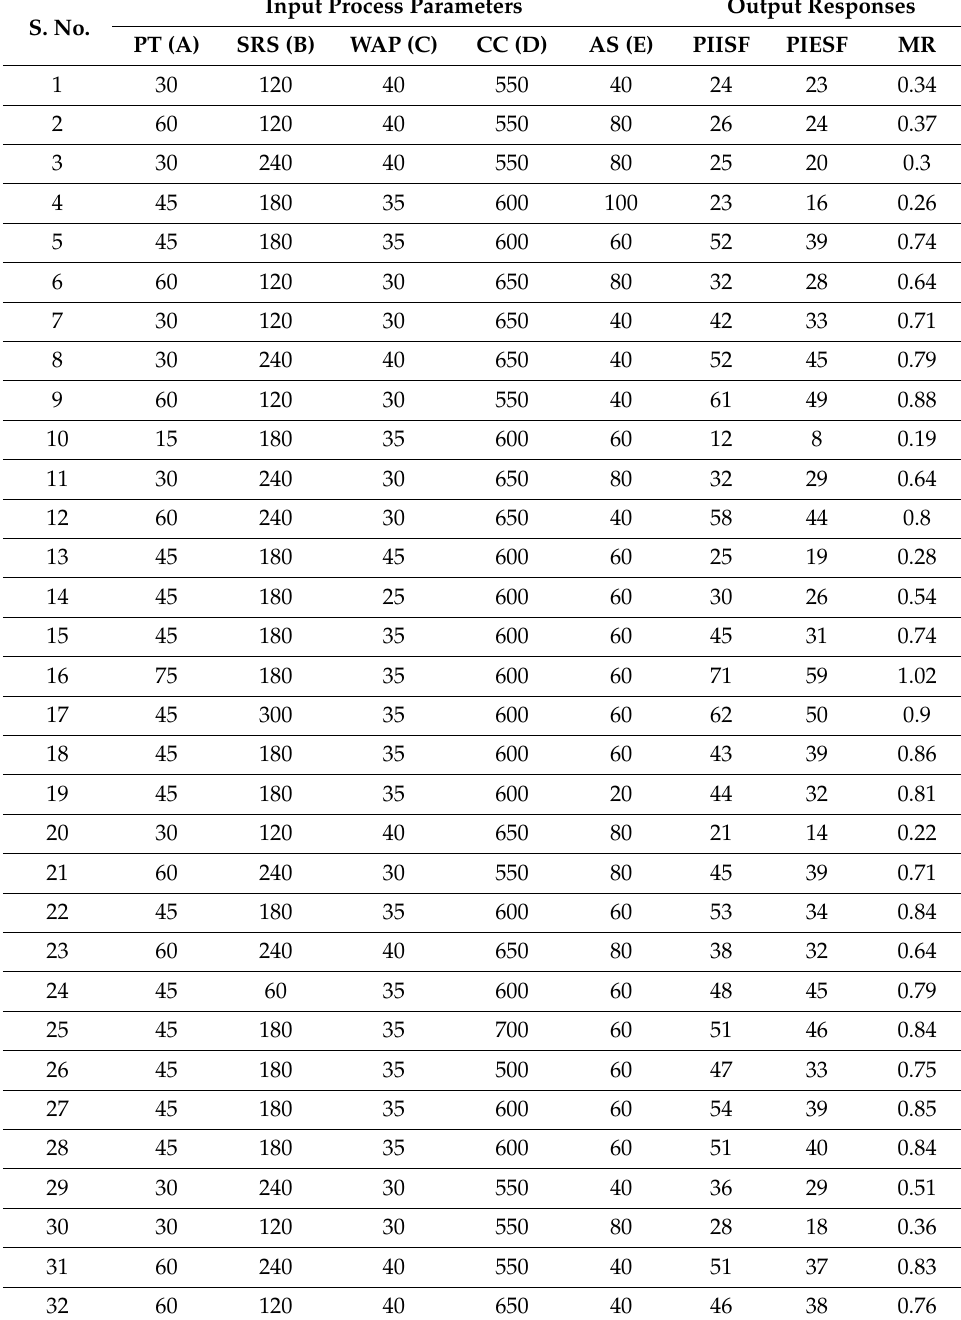
Table 2. Experimental results with